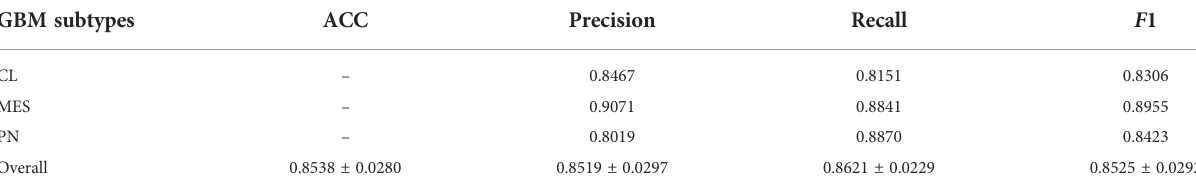
TABLE 2 The prediction results of the fi nal classi fi er constructed by RBF-based SVM using a 10-fold cross-validation test on the whole dataset (397 samples). GBM